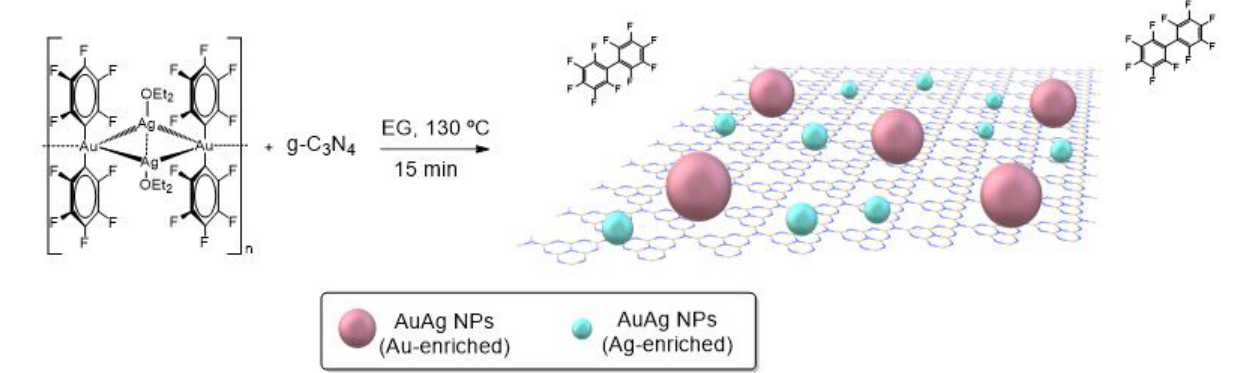
Scheme 1. Synthesis of AuAg-g-C 3 N 4 nanohybrids 2 and 3 by reduction of complex [Au 2 Ag 2 (C 6 F 5 ) 4 (OEt 2 ) 2 ] n in ethylenegly- col (EG) at 130 °C.